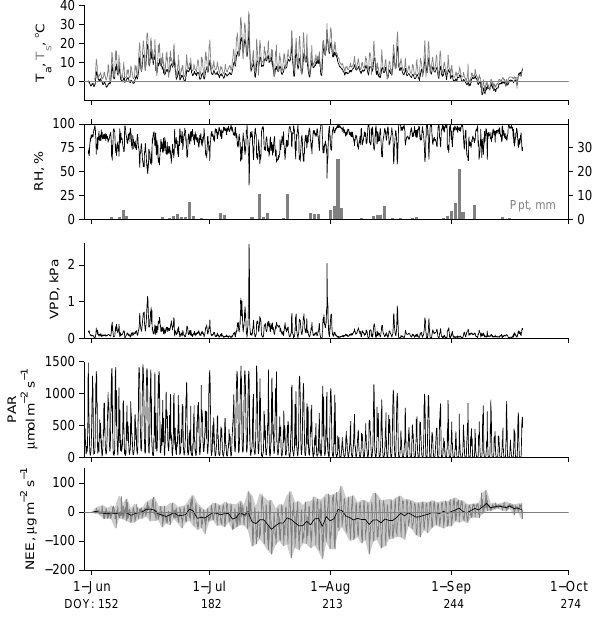
Fig. 1. Meteorological conditions and gap-filled eddy covariance measurements of the CO 2 flux for the growing season measurement period, 2006; Samoylov Island site, Lena River Delta, Russia. The meteorological data shown are air temperature ( T a ), surface temper- ature ( T s ) derived from outgoing longwave radiation, relative hu- midity (RH), vapour pressure deficit (VPD), and photosynthetically active radiation (PAR). The bottom panel presents the daily mean CO 2 flux measurements in a darker line, half-hourly estimates of net ecosystem exchange of CO 2 (NEE) in gray, and the daily range in light gray. The time series is given in calendar dates as well as day of year